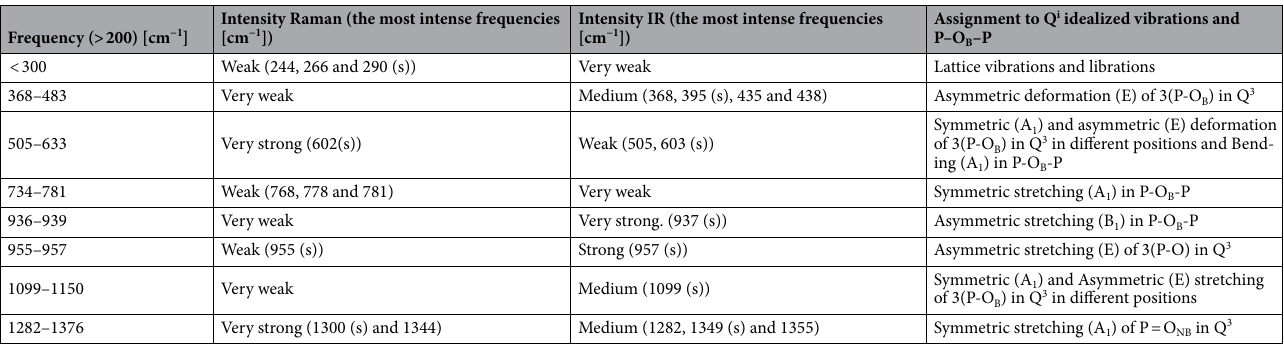
Table 1. The calculated Raman and IR active modes of o’-P 2 O 5 (more details in the supplementary material Table S1.1). s—the strongest in range.